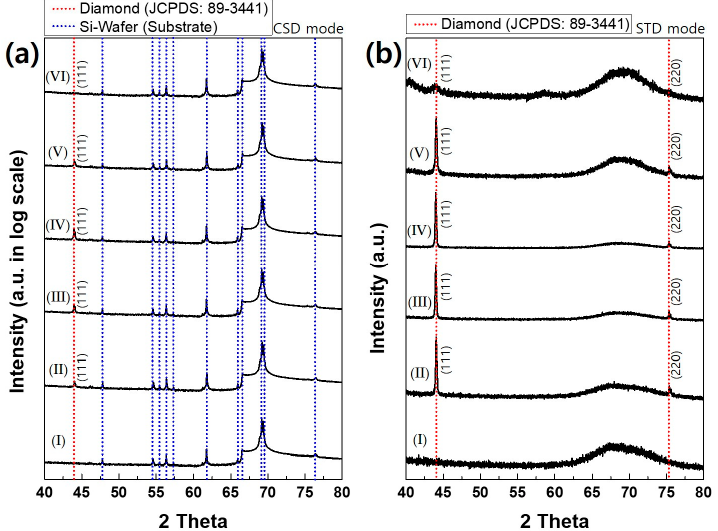
Figure 6. ( a ) Coupled scanning diffraction (CSD) and ( b ) sample tilting diffraction (STD) mode XRD patterns of (I) the silicon wafer and diamond films deposited at acetone fluxes (II) 90, (III) 130, (IV) 170, (V) 210 and (VI) 250 sccm.